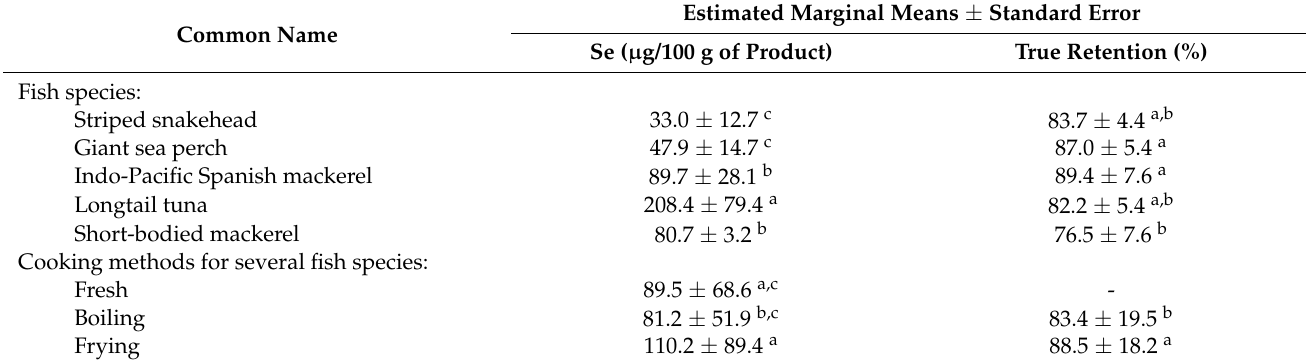
Table 5. Data on estimated marginal means of Se concentration and percentage of Se true retention by the major impacts of several kinds of fish and cooking methods ( n =